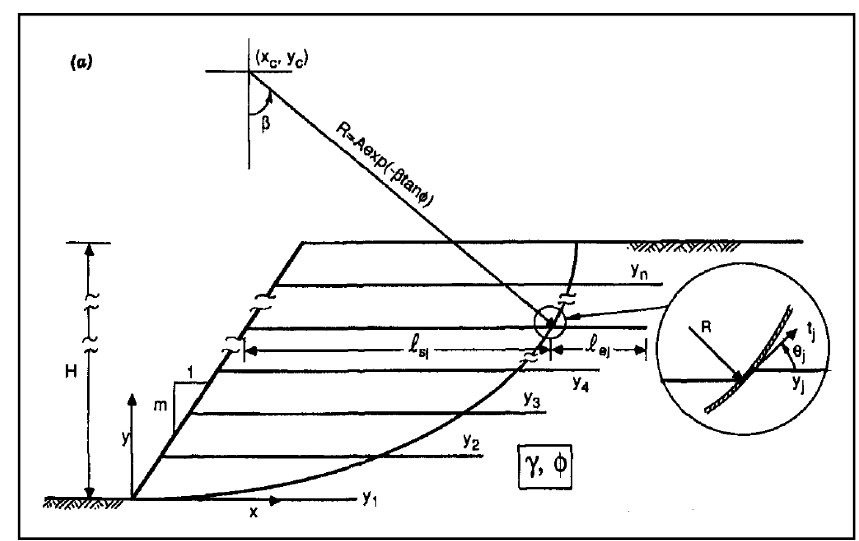
Figure 8. Leshchinsky Method of Stability Analysis [42].